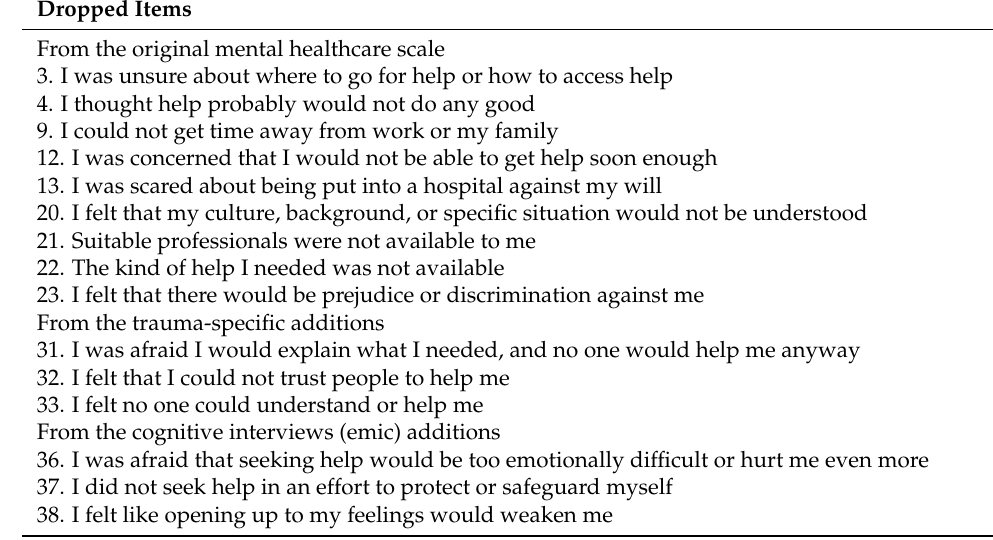
Table 5. Items removed from the Barriers to Help-Seeking for Trauma (BHS-TR) scale in the Quan phase.